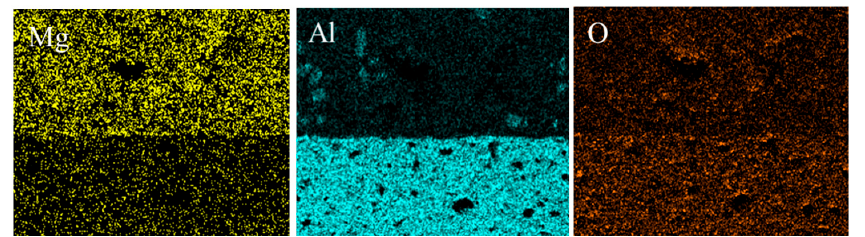
Figure 6. Element distribution of slag B. Table 2. EDS composition at different locations.